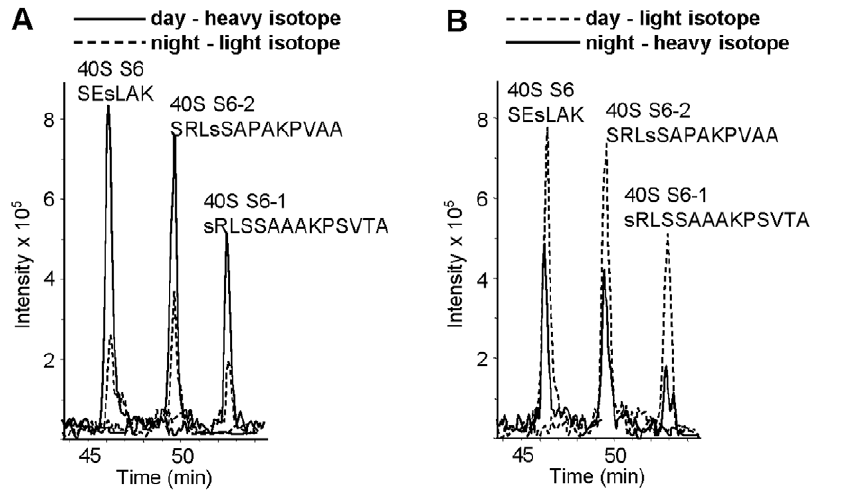
Figure 3. Quantitative mass spectrometric analysis of phosphorylated peptides from the 40S ribosomal protein S6. Ion chromatograms of three phosphorylated peptides differentially labeled with light or heavy isotopes and analyzed by nano-LC-MS. A , ion intensity peaks indicated with continuous line correspond to peptides SEs 231 LAK with M/Z=748.3, SRLs 240 SAPAKPVAA with M/Z=676.3 and SRLs 240 SAAAKPSVTA with M/Z=721.8 from plants harvested during day time and labeled by heavy, d3-methanol. Ion intensity peaks indicated with dashed line correspond to the same peptides obtained from the plants harvested during night and labeled by light h3-methanol. M/Z values for the light isotope labeled phosphopeptides are 742.3, 674.8 and 720.3, correspondingly. The sequences of the phosphorylated peptides from S6 are shown above the corresponding peaks. B , ion intensity peaks as in A except that the peptides from the plants harvested during day were labeled with light isotope (dashed line) and the peptides from the plants harvested during night were labeled with heavy isotope (continuous line). doi:10.1371/journal.pone.0029307.g003 phase of photoperiod are still unknown, while our findings suggest a possibility of diurnal regulation of translation in plants by differential combinatorial phosphorylation of at least three ribosomal proteins: the 40S ribosomal proteins S6-1 and S6-2, and the 60S ribosomal protein L29-1.